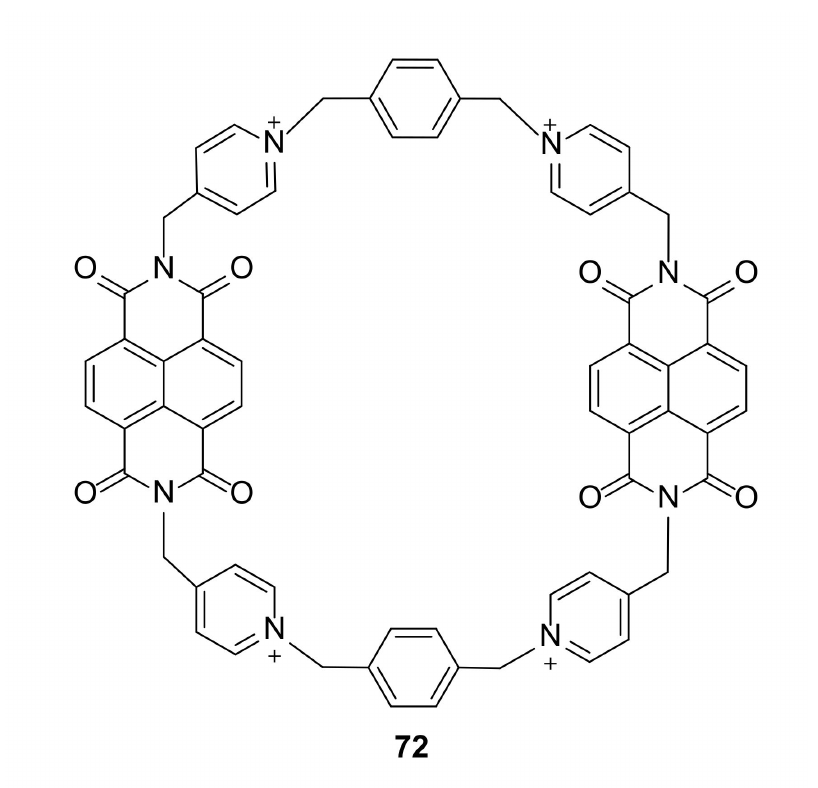
Figure 12. Tetrameric macrocycle 72 with bipyrridynium units displaying high conductivity. Cyclic voltammograms show different properties of 72 in comparison to analogue acyclic compounds having the same structural components. Macrocycle 72 displayed semiconductive electron properties with high electron affinity (4.2 eV) in the solid state. A thin film of 72 displayed a maximum redox conductivity of 7.6 × 10 − 4 Sm − 1 , which makes it potentially usable in organic